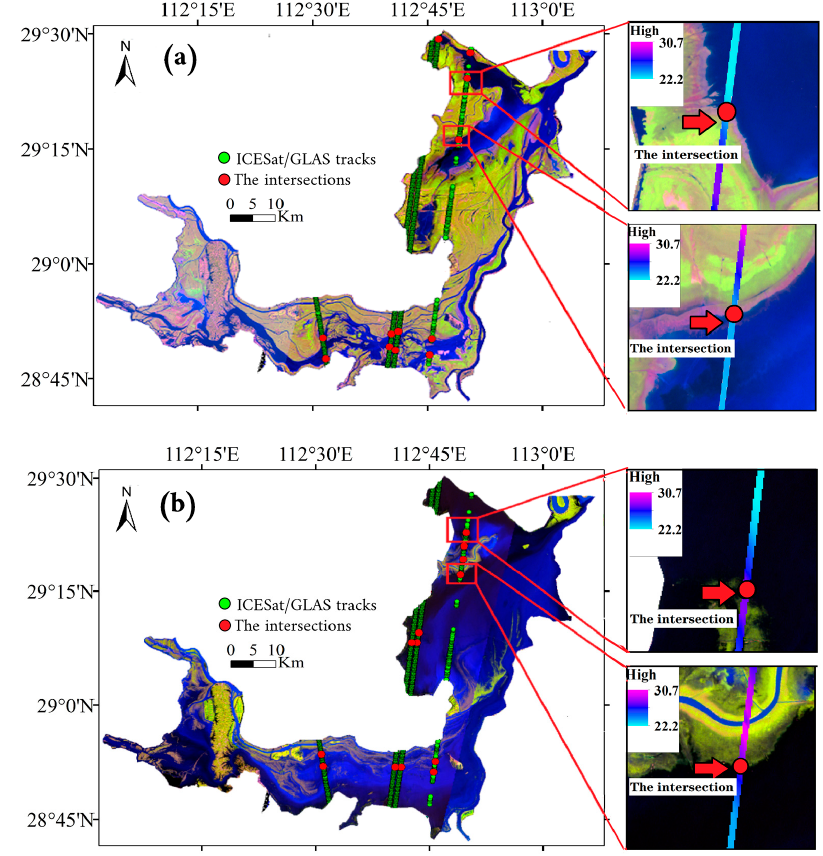
Figure 3. Intersections of ICESat/GLAS with lake boundaries at different water levels in the Dongting Lake area: ( a ) low water level, ( b ) high water level.